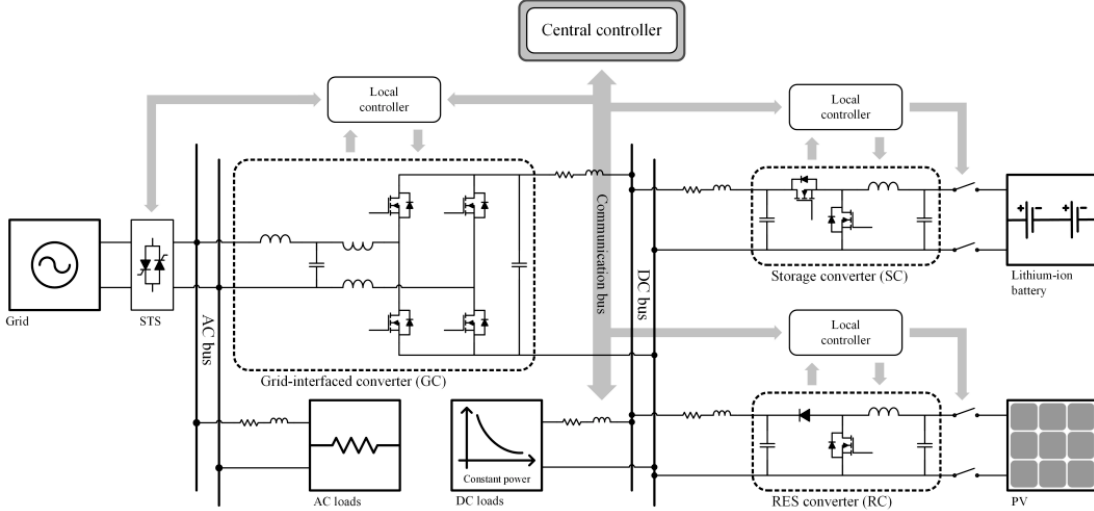
Figure 1. System diagram of hybrid ac/dc microgrid with communication links.